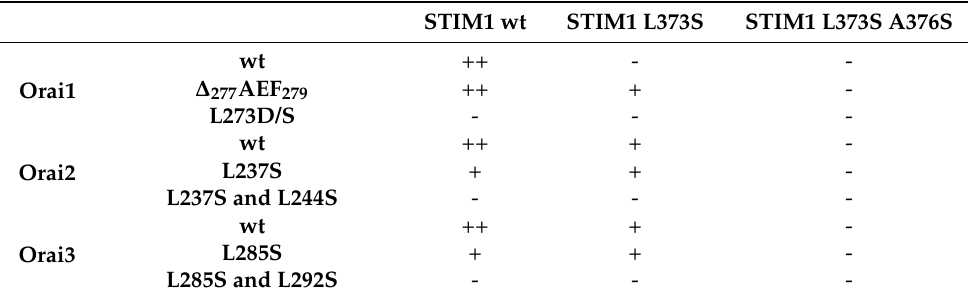
Figure 2. Isoform-specific similarities and differences of Orai homologues. ( A – C ) Orai1, Orai2 and Orai3 are shown in comparison with the analogous residues highlighted in black that represent critical conserved amino acids, while the red marked residues are non-conserved positions among the three isoforms. Blue arrows illustrate the regions important for pore opening, yellow arrows are areas important for STIM1/Orai1 coupling and pore opening while green arrows highlight the regions merely responsible for STIM1/Orai1 interaction. Structurally, Orai homologues are rather similar, consisting of four TM domains with N and C termini exposed into the cytosol. It is worth noting that Orai3 possesses a longer loop3 region. ( D ) The sequence alignments display positions of non-conserved residues (in red) within important Orai segments determining distinct isoform- specific behavior. ( E ) The cytosolic triangles containing functional relevant salt-bridge interactions of R83-E149 and K85-E173 within one subunit and K85-E149 between two subunits. ( F ) The table summarizes the activity of three Orai isoforms upon application of different modulators. The small and large green arrows define the slight or robust potentiation, respectively, while red arrows are a slight or robust blockage (n.d. = not determined). Table 4. Isoform-specific differences in the coupling of Orai C-termini to